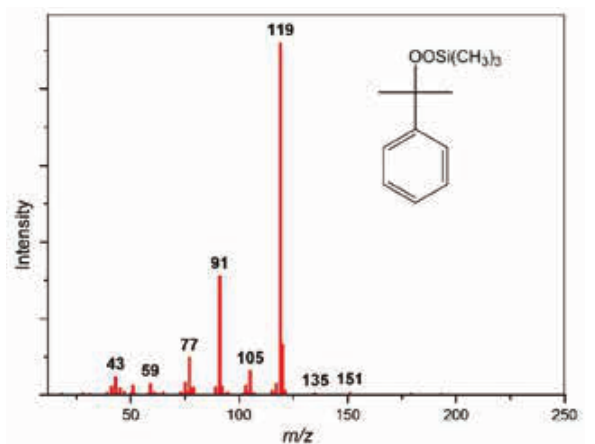
Figure 4. Mass spectra of the TMS derivative of cumene-HP.